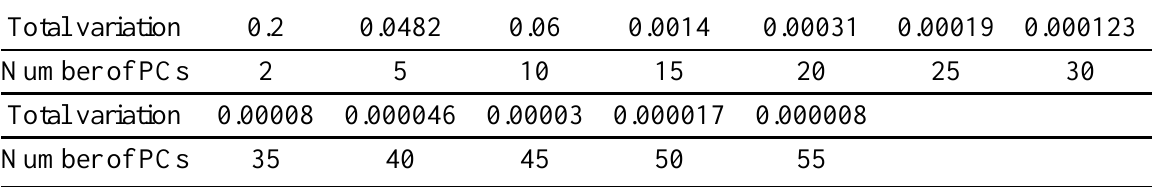
Table 5. Total variation with its corresponding number of